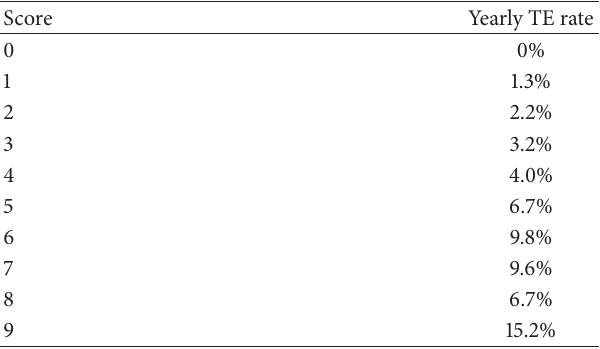
Table 4: The CHA2DS2-VASc score: theoretical risk of stroke/ thromboembolism per patient year without anticoagulation (modi- fied from [82]).